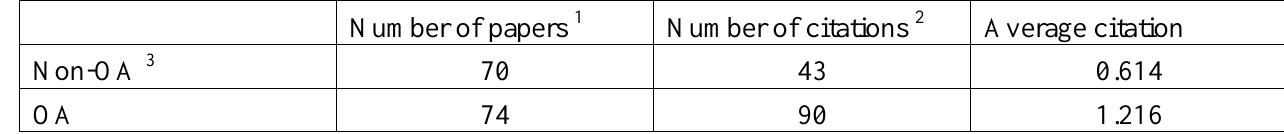
Table 1. Open Access (OA) and non-Open Access (non-OA) papers published in Molecules in 2005